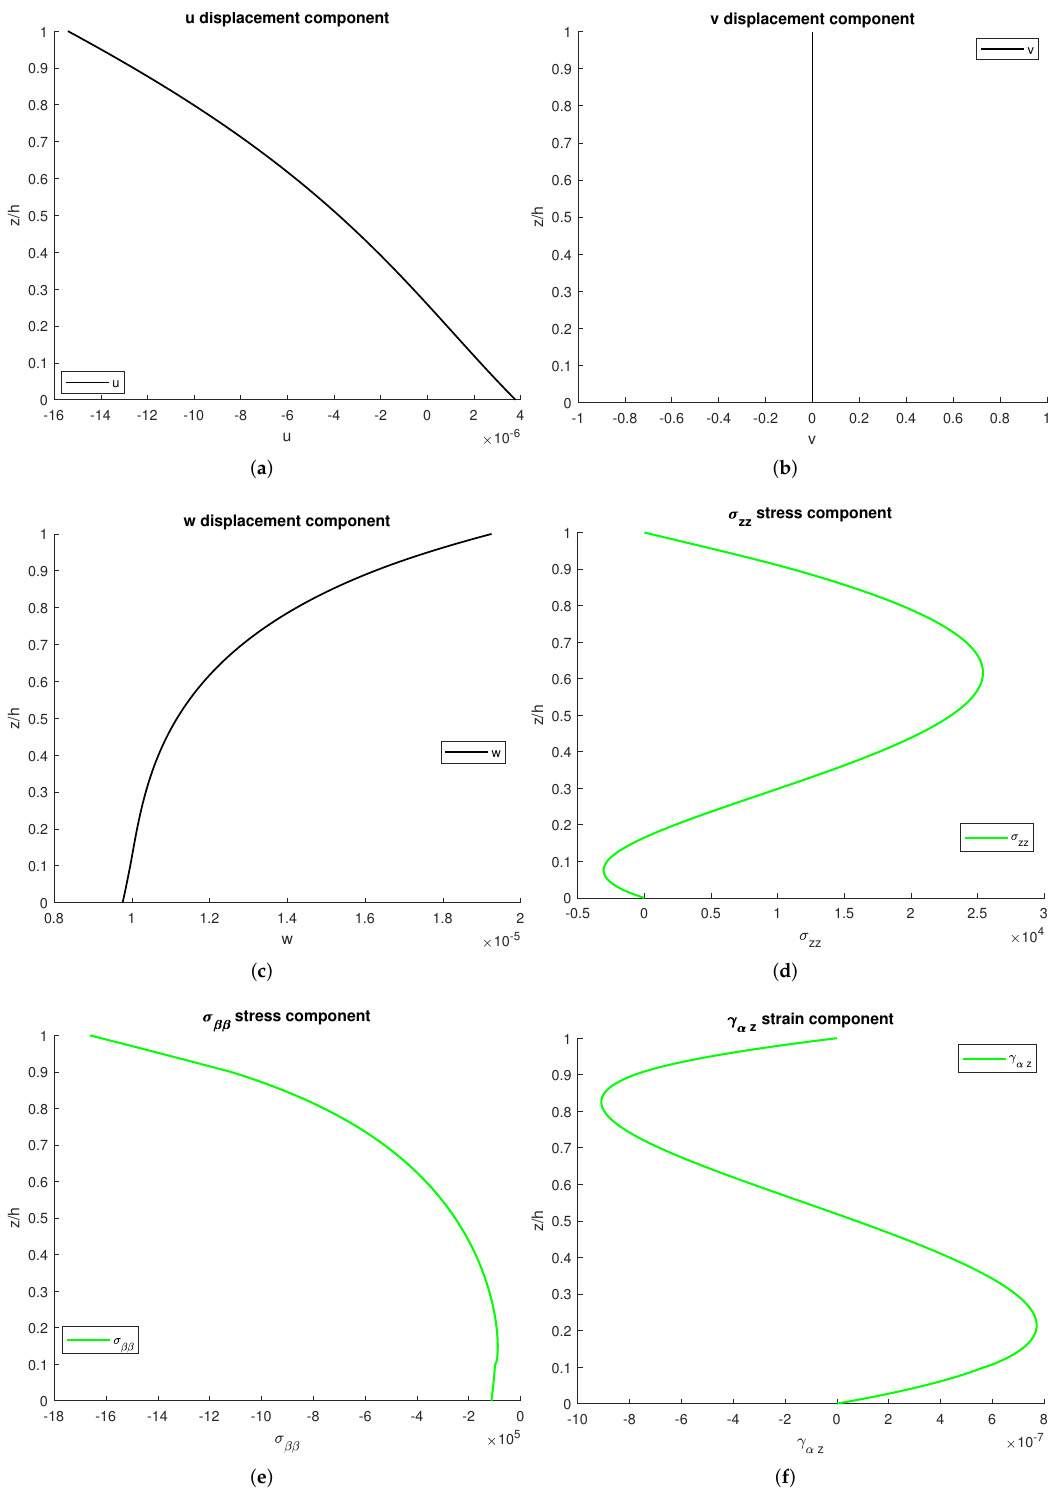
Figure 8. Third benchmark: cylindrical sandwich shell panel featuring an FGM ( p = 0.5) core with an imposed moisture content on the top and bottom surfaces. The results are calculated for a thick ( R α / h = 4) structure via the 3D( M c ,3 D ) model. ( a ) Amplitude of u displacement component. ( b ) Amplitude of v displacement component. ( c ) Amplitude of w displacement component. ( d ) Am- plitude of σ zz stress component. ( e ) Amplitude of σ ββ stress component. ( f ) Amplitude of γ α z strain